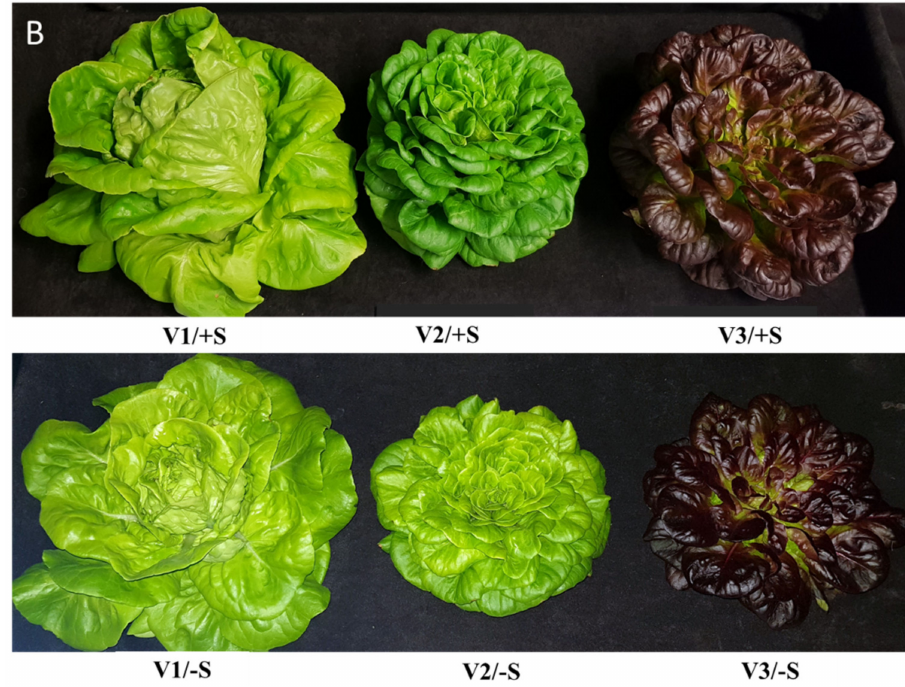
Figure 1. Biomass productions in three lettuce cultivars, namely, Pazmanea RZ (green butterhead, V1), Hawking RZ (green multi-leaf lettuce, V2), and Barlach RZ (red multi-leaf, V3) grown in hydroponic system and treated with magnesium sulfate (+S) or magnesium chloride ( − S) at a final concentration of 0.5 mM. ( A ): Side view ( B ): Top view of the lettuce heads.